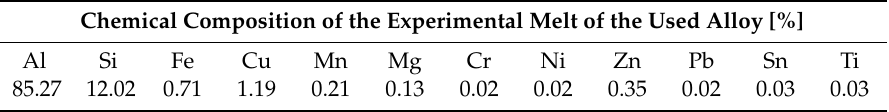
Table 1. Chemical composition of